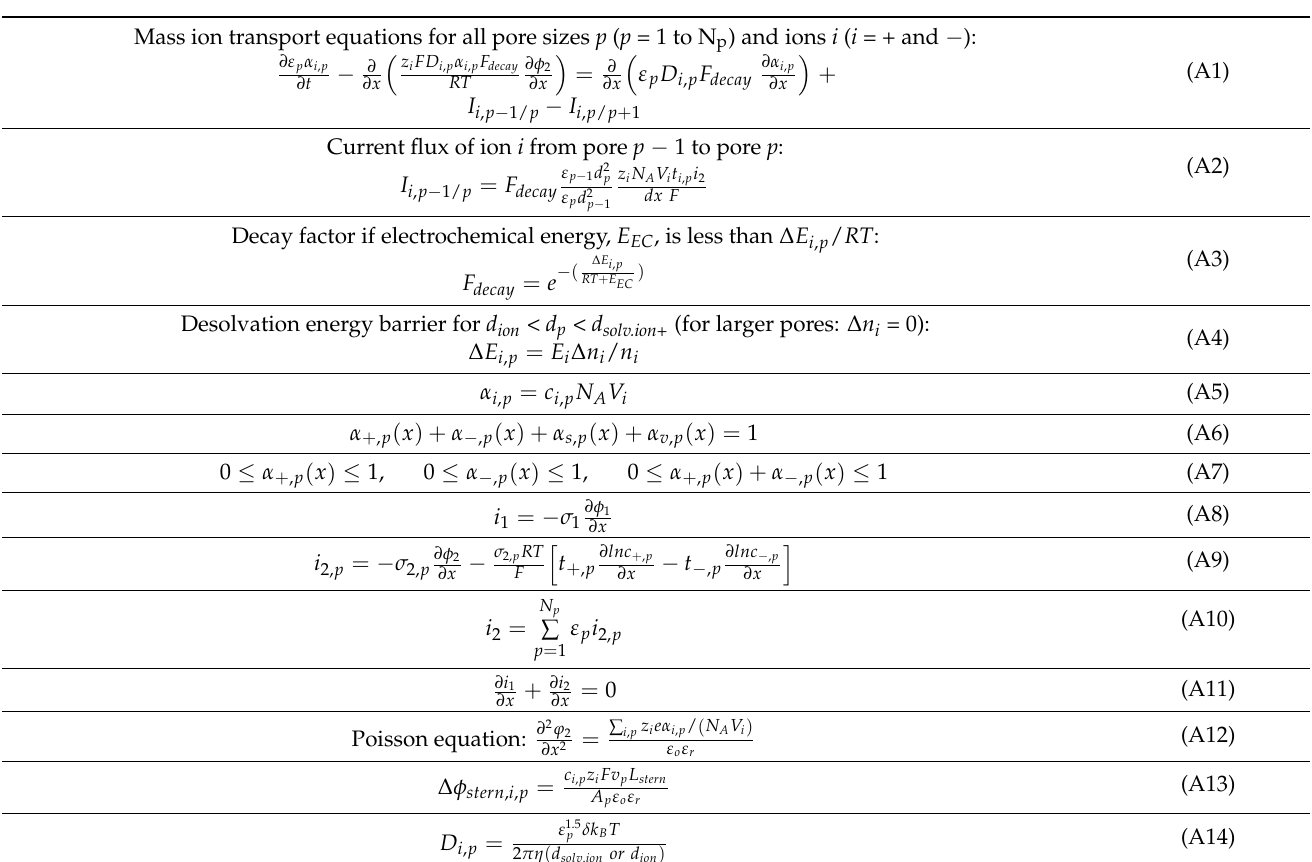
Table A1. Equations of the continuum model of the electrochemical processes in EDLCs. Mass ion transport equations for all pore sizes p ( p = 1 to N p ) and ions i ( i = + and − ): (cid:16) z ∂ε p α i , p i FD i , p α i , p F decay − ∂ ∂ t ∂ x